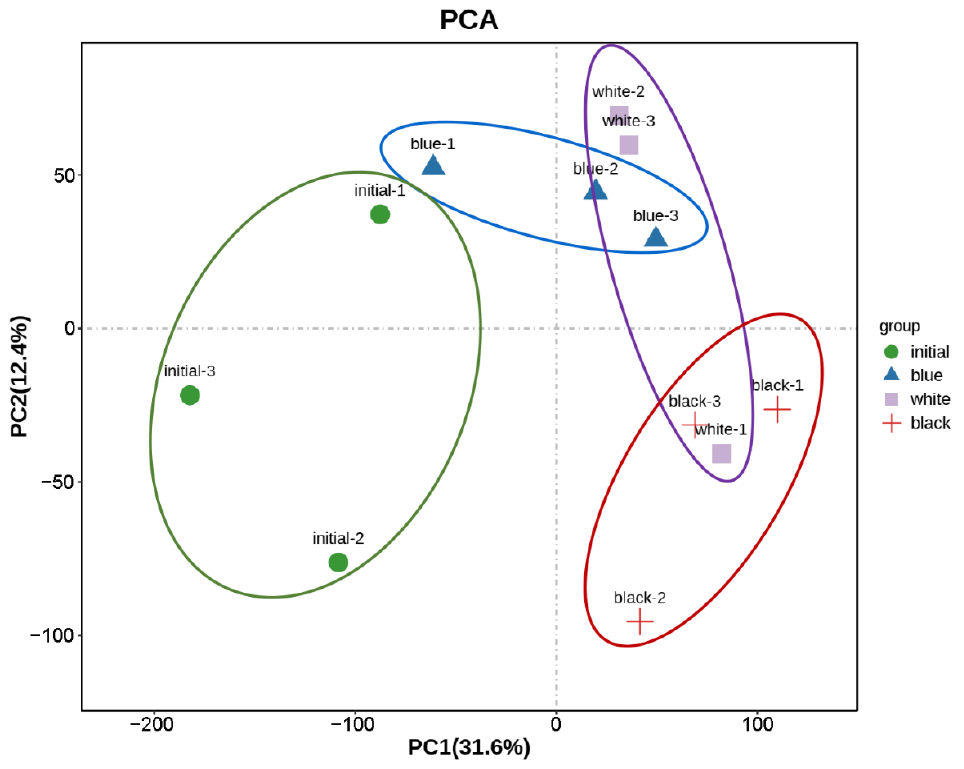
Figure 3. PCA analysis of the 12 datasets.